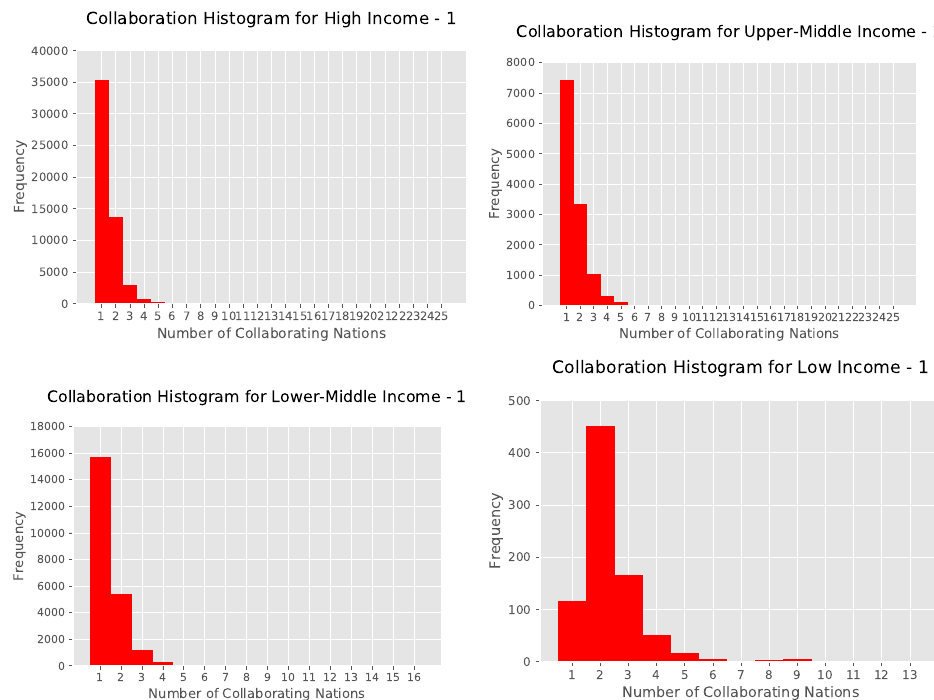
Figure 18. The distribution of distinct nations represented on papers in the natural sciences by income group.